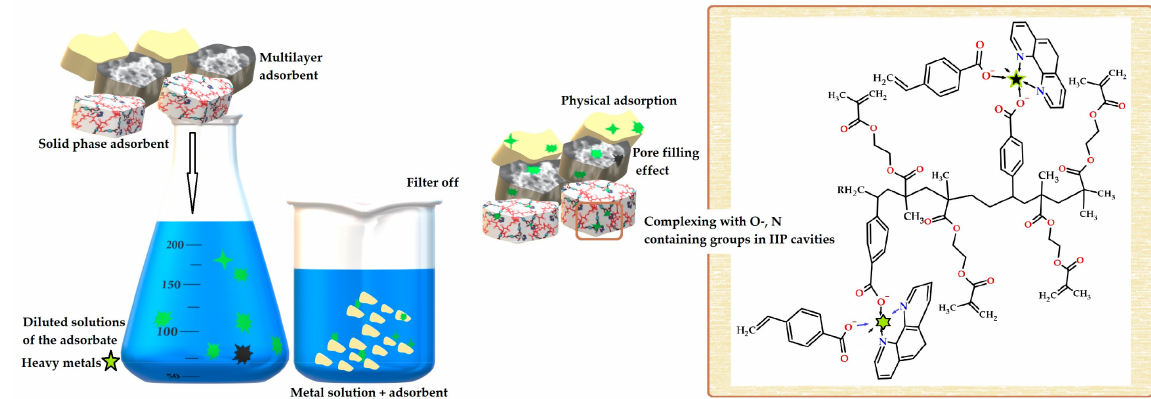
monomer; Table S1: SEM micrographs and average particle diameters of the prepared materials, IIP, MIP and functional